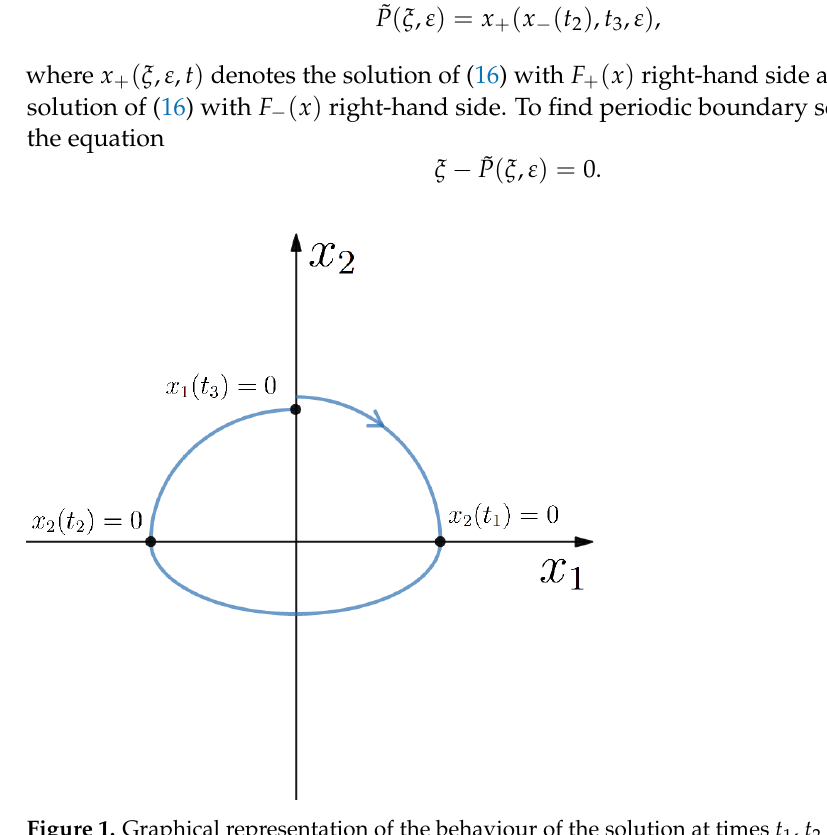
Figure 1. Graphical representation of the behaviour of the solution at times t 1 , t 2 and t 3 . Differentiating the Equation (11) with respect to ξ at the point ( ξ , ε ) = ( x 0 ,0 ) we